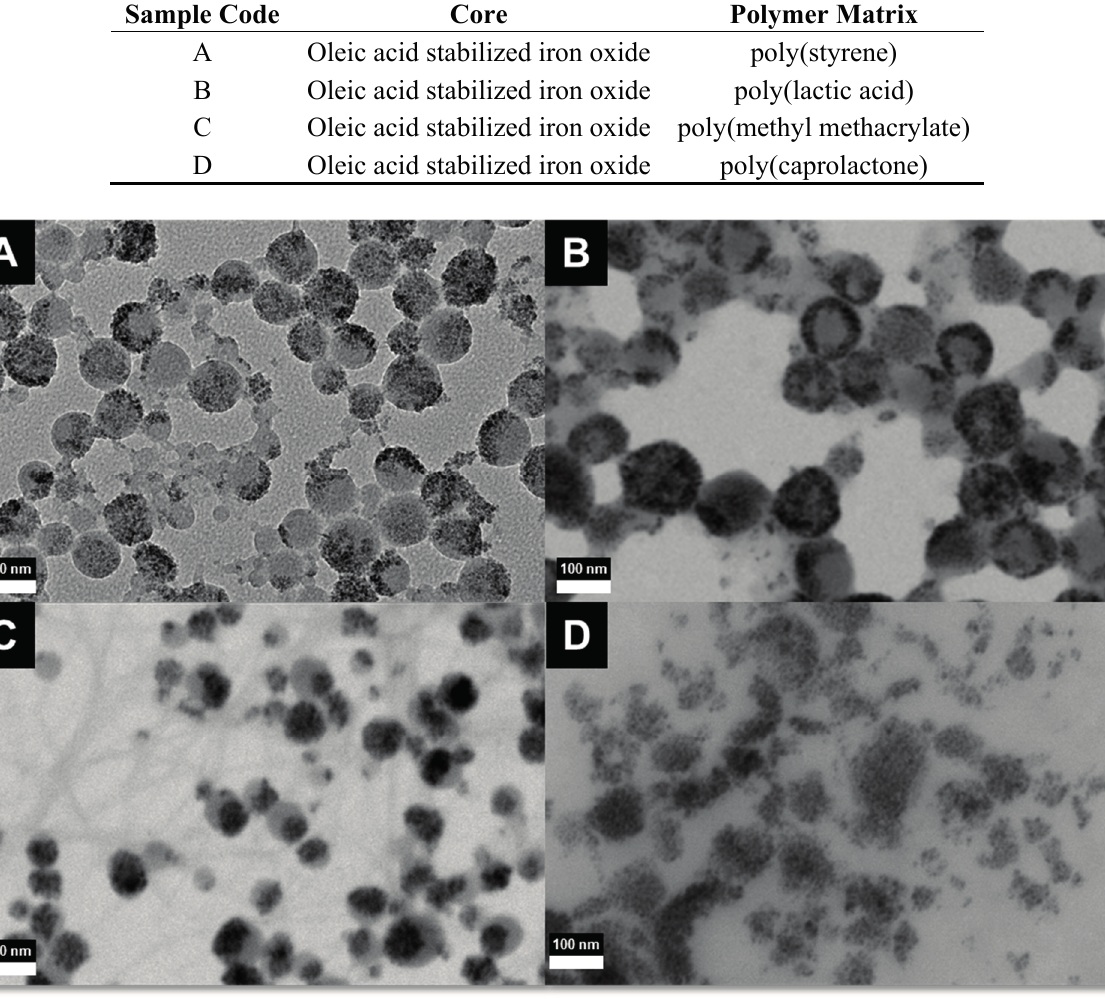
Figure 2. TEM micrograph of sample A , STEM (scanning transmission electron microscope) micrographs of sample B , C , and D (scale bars 100